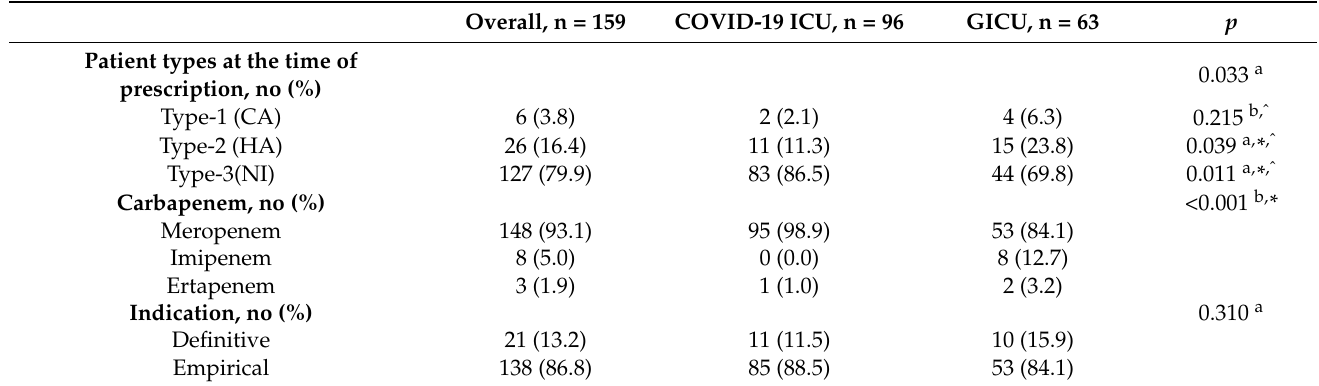
Table 3. Characteristics of all carbapenem prescriptions.